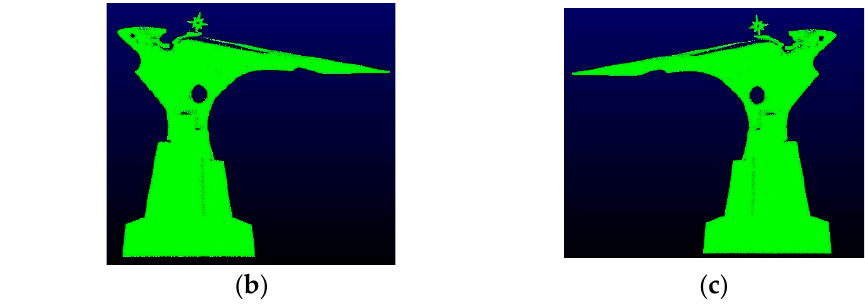
Figure 7. Projected view of TLS point cloud in different directions. ( a ) Top view. ( b ) Front view. ( c ) Rear view.